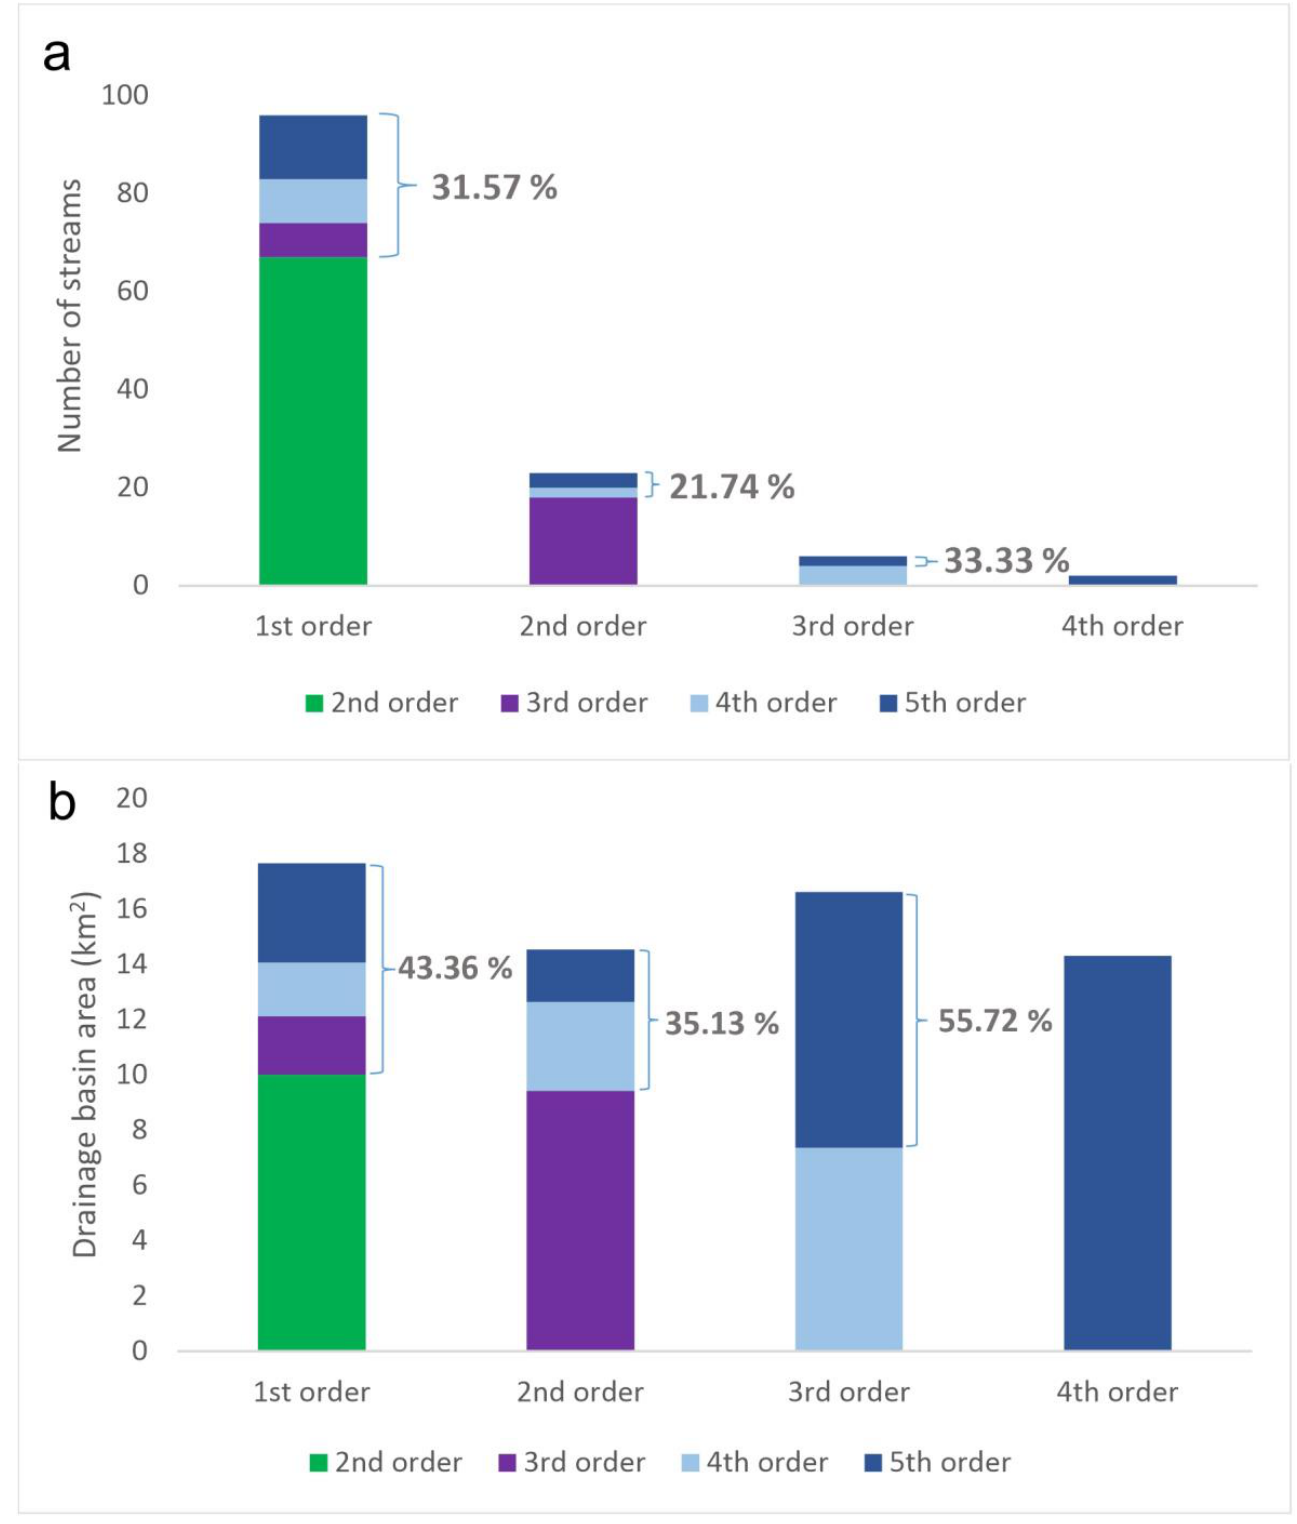
Figure 4. Hierarchical drainage by stream order for Kladeos River drainage network (a. Number of streams and b. Drainage basin area).